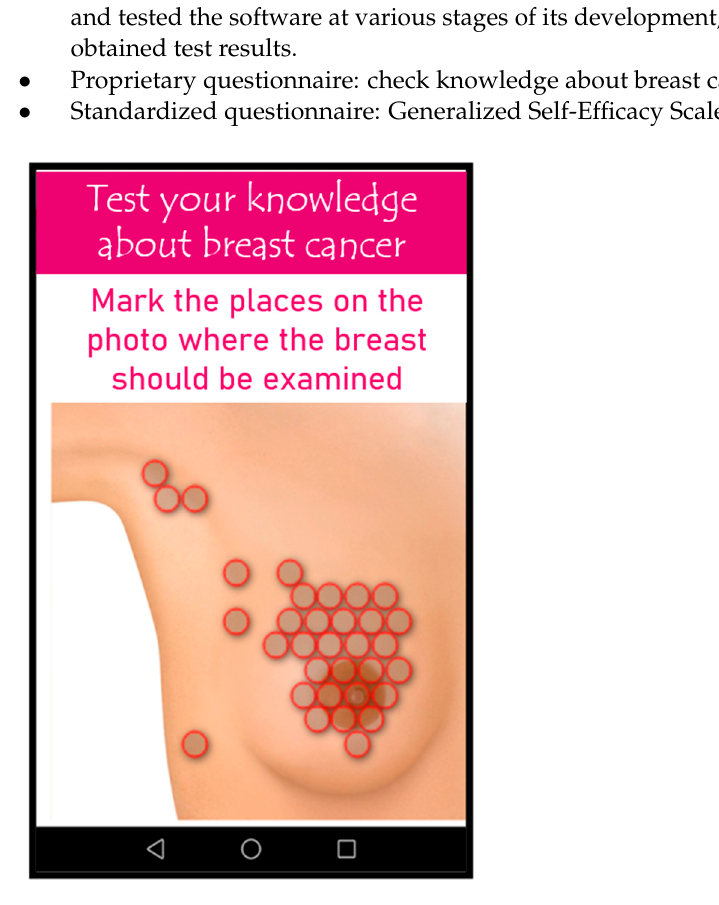
Figure 3. The image of the proprietary interactive tactile test—breast self-examination.